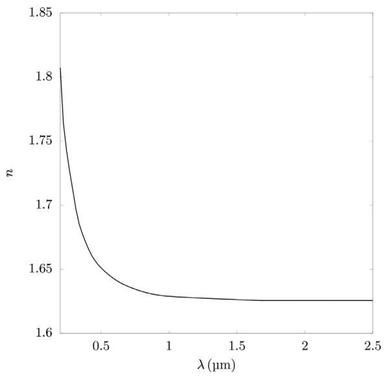
Refractive index of alumina–mullite .